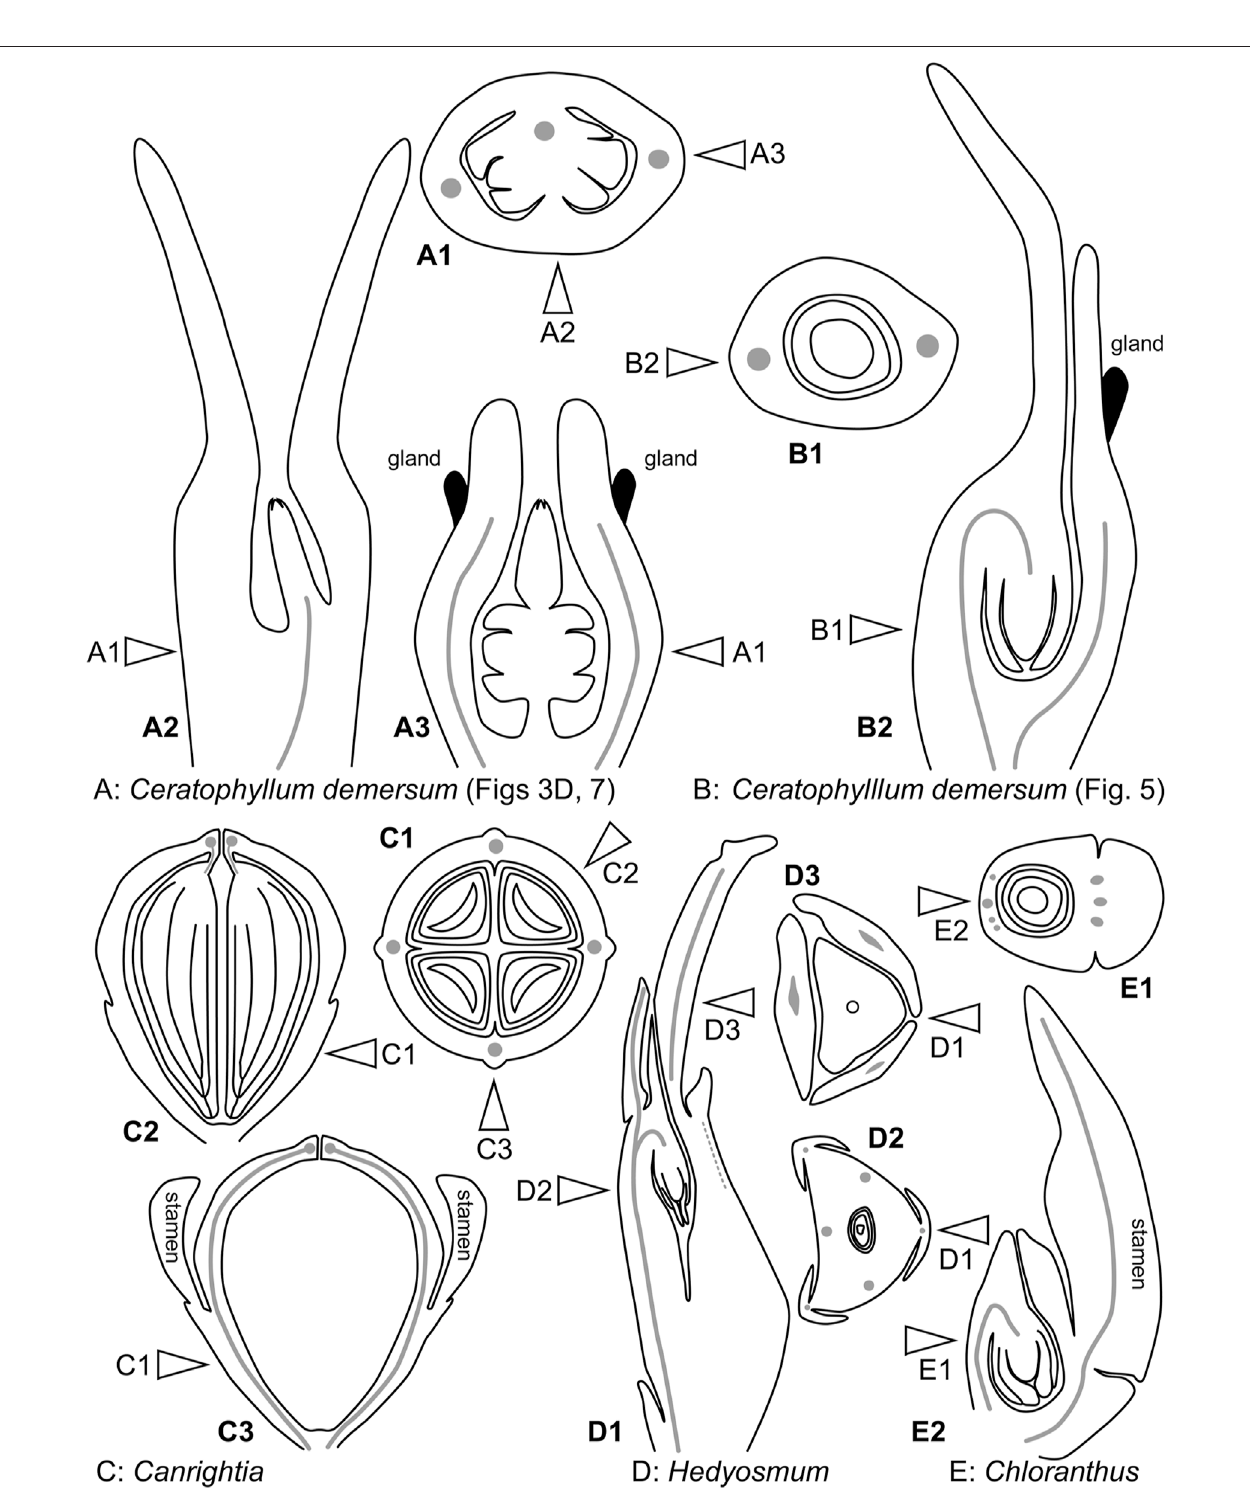
FIGURE 14 | Diagrams of pistillate or bisexual fl ower morphology in Ceratophyllum and some of its possible phylogenetic relatives. In each case, longitudinal and cross-sectionsareprovided,withtheirpositionsreciprocallyindicatedbyarrows. (A) Oneoftherareconditionsobservedherein Ceratophyllumdemersum ( Figures3D , 7 ). (B) The most common type of pistillate fl ower in Ceratophyllum . (C) Cretaceous fossil Canrightia (modi fi ed from Friis and Pedersen, 2011). (D,E) Extant members of Chloranthaceae. (D) Hedyosmum (modi fi ed from Endress, 1971). (E) Chloranthus (modi fi ed from Endress, 1987b).